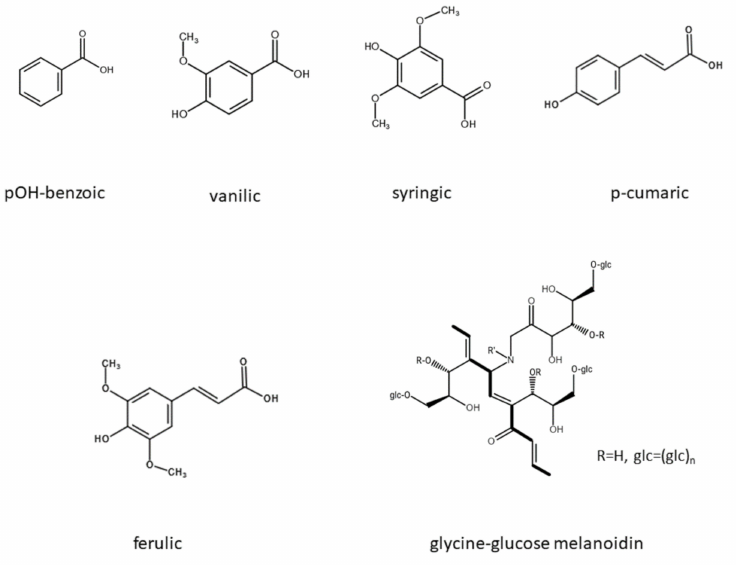
Figure 2. The structure of polyphenols and melanoidin (based on [51]) typical for the distillery